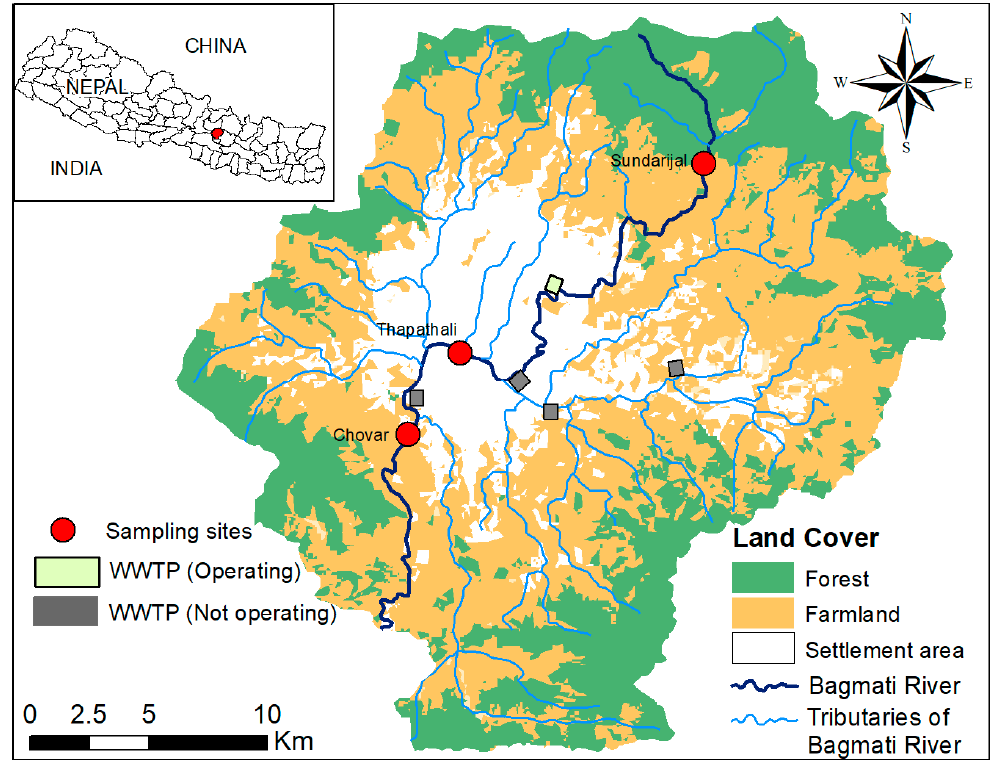
Figure 1. Locations of sampling sites with land cover usage in the Kathmandu Valley.